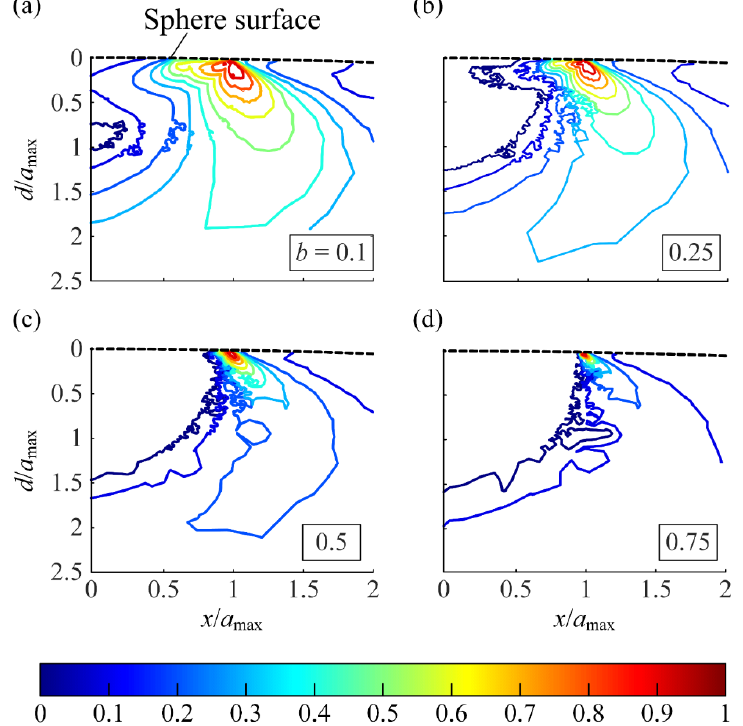
Figure 12. The contour of FSDP/(FSDP)max at the sphere tip when P * max = 700 for b = ( a ) 0.1, ( b ) 0.25, ( c ) 0.5 and ( d ) 0.75.